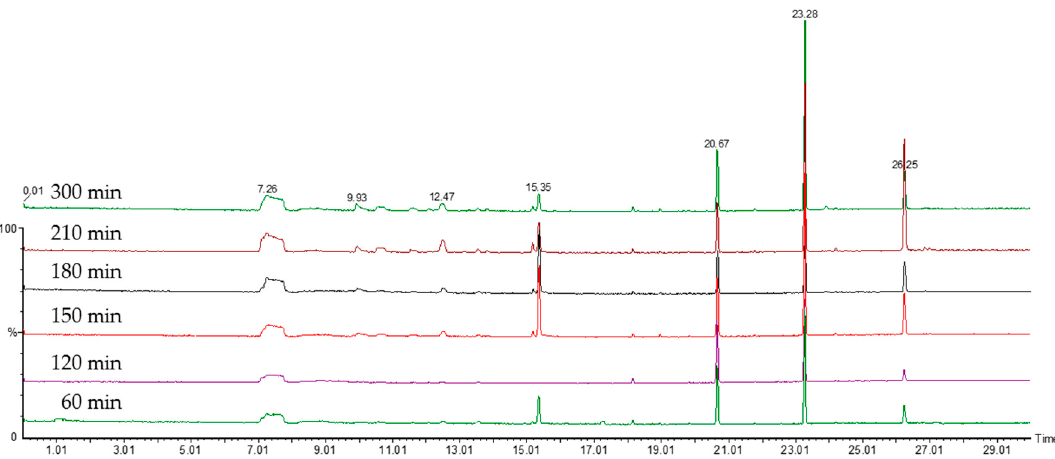
Figure 2. Optical and cell density of laboratory strain of E. coli used in preliminary experiments.